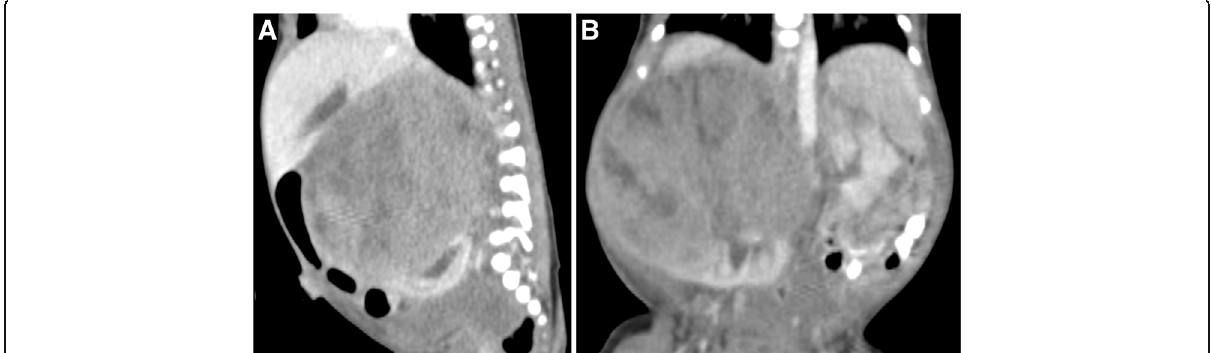
Fig. 2 A CT scan — sagittal view — showing the claw-like renal tissue and the hilum position which displaced medially and posteroinferiorly. B CT scan — coronal view — of the mass